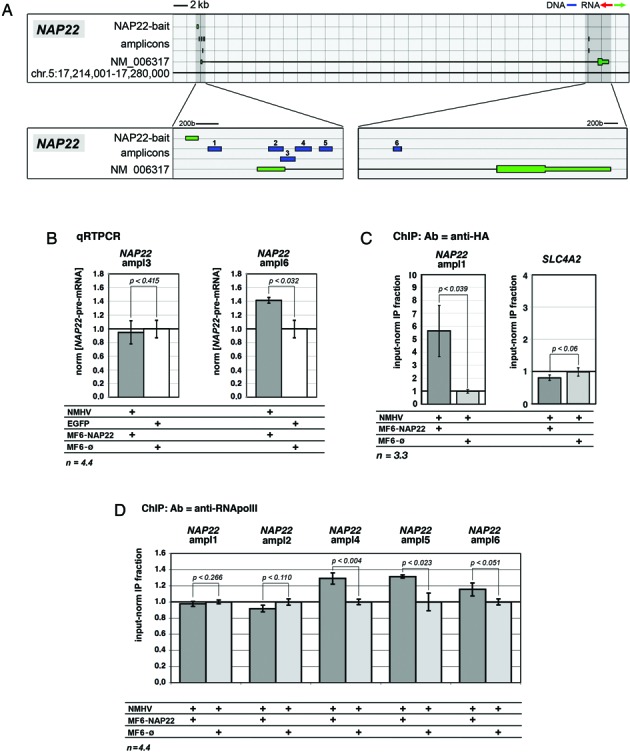
Mechanisms underlying NAP22 transactivation in HEK293T cells. (A) Schematics of the NAP22 locus with NAP22-bait and diagnostic amplicons employed for the analysis. (B) Modulation of NAP22-pre-mRNA in NMHV/MF6-NAP22-expressing cells, evaluated by intronic qRTPCR. Results were normalized against GAPDH and further normalized against the EGFP/MF6-øcombination. (C) Recruitment of NMHV at NAP22 promoter in NMHV/MF6-NAP22-expressing cells, evaluated by anti-HA-ChIP/qPCR. The potential NAP22-offtarget SLC4A2 was used as a specificity control. (D) RNApolII binding at different sites of the NAP22 locus in NMHV/MF6-NAP22-expressing cells, evaluated by anti-RNApolII-ChIP/qPCR. In (C, D) results were normalized against input chromatin and further normalized against the NMHV/MF6-øcontrol. Noticeably, in (B, D) cells were transfected by the ‘Lipofectamine 3000 protocol’. In (B-D) cell culture timing was as described in Figure 1. Numbers of biological replicates, n, are displayed under the graphs. Bars represent s.e.m.'s.